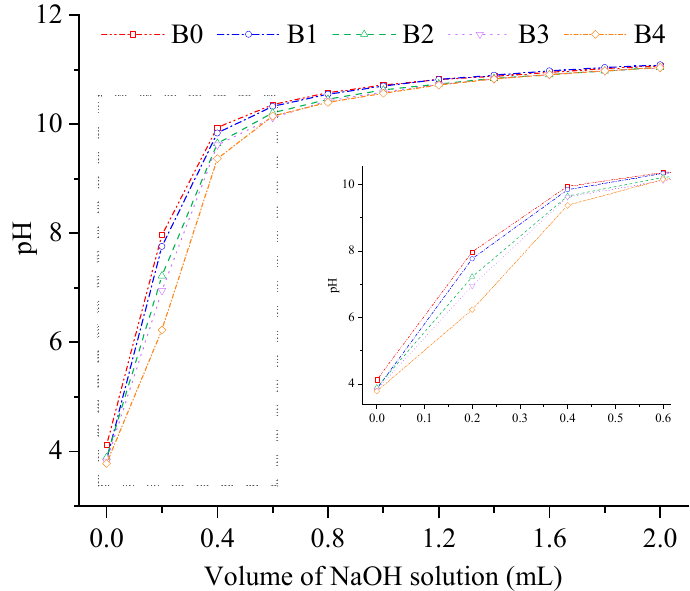
Figure 9. Cation exchange capacity of the wheat bran. The B0, B1, B2, B3, and B4 are the wheat bran